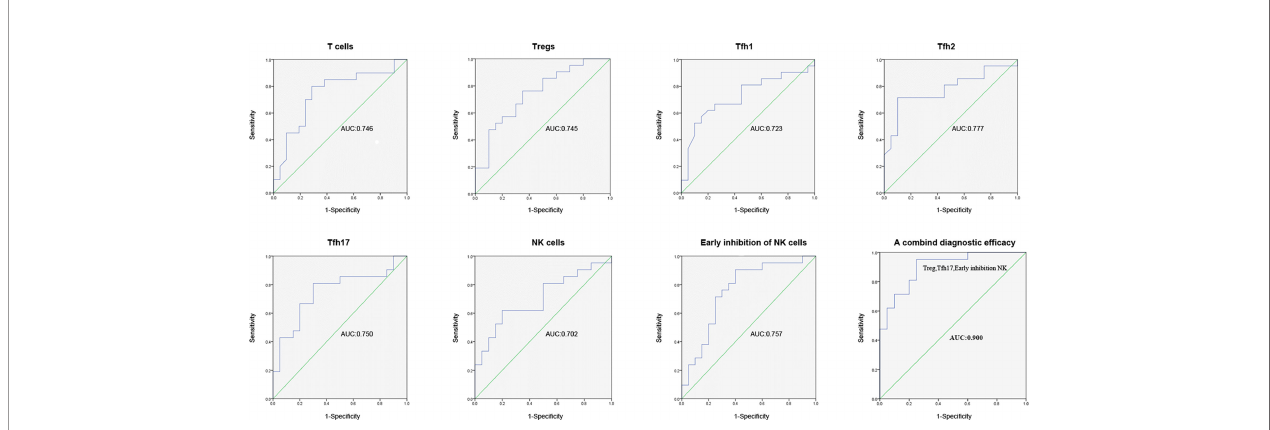
FIGURE 2 | ROC curve for the ef fi ciency of single (Tregs, Tfh1, Tfh2, Tfh17, and early inhibitory NK cells) and of combined biomarker diagnosis for RIF. ROC, receiver operating characteristic; RIF, recurrent implantation failure, NK, natural killer; Tregs, regulatory T; Tfh, T follicle